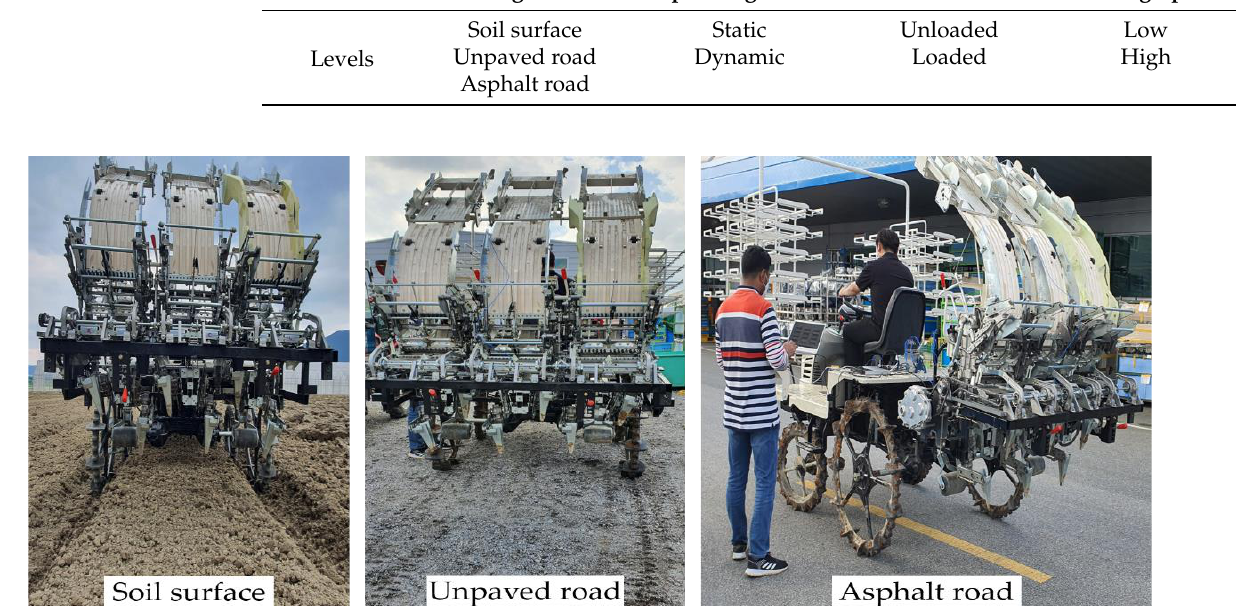
Figure 3. Vibration measurement under different driving surface conditions.